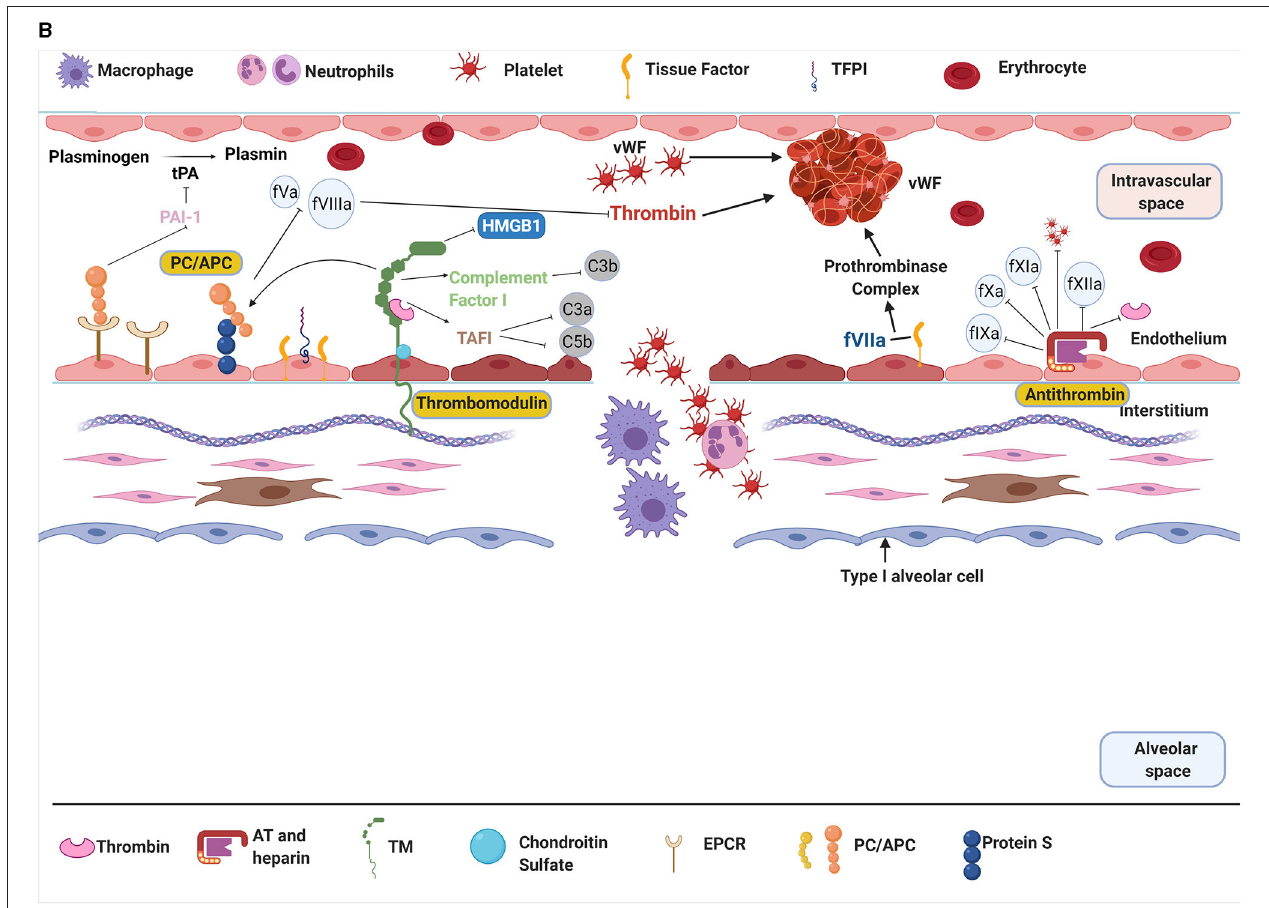
FIGURE 2 | (A,B) The interaction of inflammation and coagulation in ARDS. NET, Neutrophil Extracellular Trap; vWF, von Willebrand Factor; TFPI, Tissue Factor Pathway Inhibitor; IL-, Interleukin; NE, Neutrophil Elastase; ROS, Reactive Oxygen Species; TNF α , Tumour Necrosis Factor α ; MMP, Matrix Metalloproteinases; TF, Tissue Factor; tPA, tissue Plasminogen Activator; PAI-1, Plasminogen Activator Inhibitor-1; HMGB1, High Mobility Group Box protein 1; C3/5 a/b, Complement factor; TAFI, Thrombin Activatable Fibrinolysis Inhibitor; PC, Protein C; TM, Thrombomodulin; EPCR, Endothelial Protein C Receptor; AT, Antithrombin. The role of coagulation and inflammation are intrinsically linked together, both occurring in parallel in ARDS. Ultimately their dysfunction leads to the damage seen in ARDS patients. (A) The endogenous anticoagulants PC, TM, and AT are responsible for controlling coagulation. These proteins respond to a procoagulant/pro-inflammatory environment